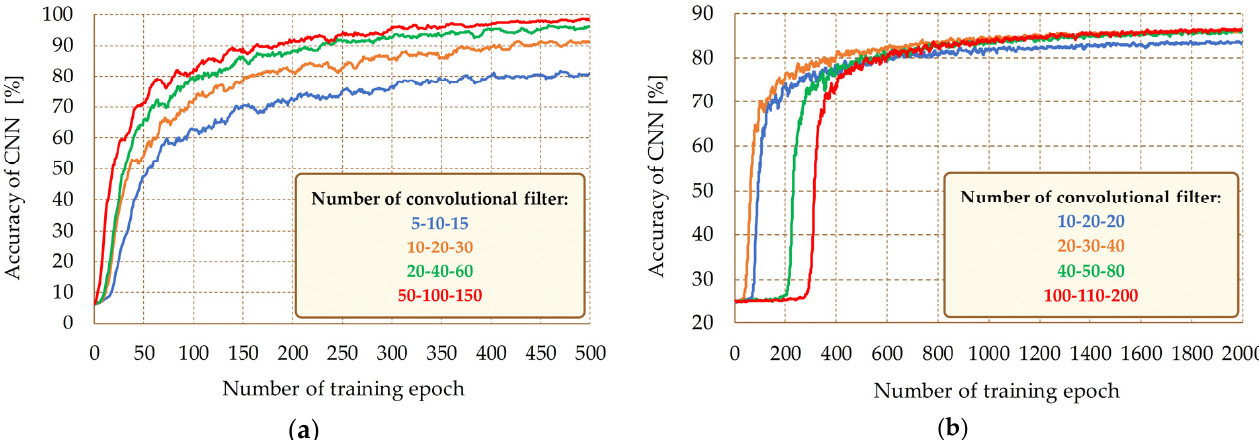
Figure 7. Influence of the number of convolutional filters on the precision of the diagnostic system— learning curves: ( a ) induction motor; ( b ) PMSM.